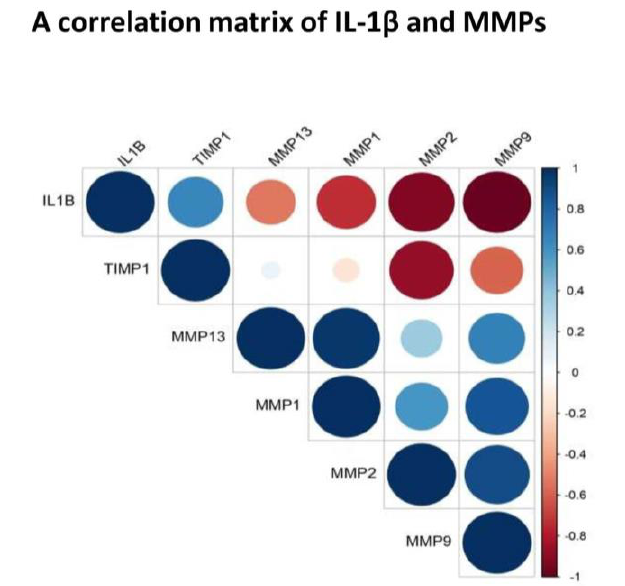
Figure 5. Correlation matrix of IL-1β, MMP-1, MMP-13, MMP-2, MMP-9 and TIMP−1. The matrix was developed using a cumulative mean value (mean of all grades) estimated from SF for each selected marker. It revealed a negative correlation between—IL-β and MMP-1 (correlation coefficient: −0.74); IL-1β and MMP-2 (correlation coefficient: −0.92); IL-1β and MMP-9 (correlation coefficient: −0.98); IL-1β and MMP-13 (correlation coefficient: −0.52); It showed a strong positive cor- relation between MMP-1 and MMP-13 (correlation coefficient: 0.96) as well as between MMP-2 and MMP-9 (correlation coefficient: